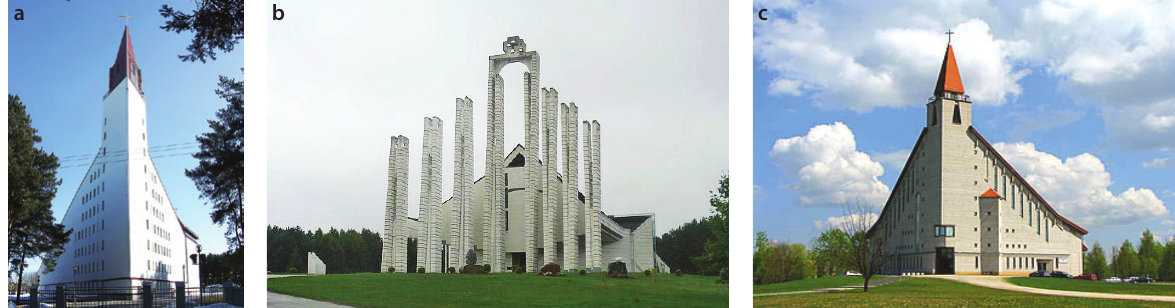
Fig. 6. Churches of Integral model: a – Church of Blessed Virgin Mary Star of Seas in Šventoji (archit. R. Krištapavičius and G. Aperavičius, 1991), b – Church of Blessed Virgin Mary Queen of Martyrs in Elektrėnai (archit. H. Šilgalis, 1996), c – Church